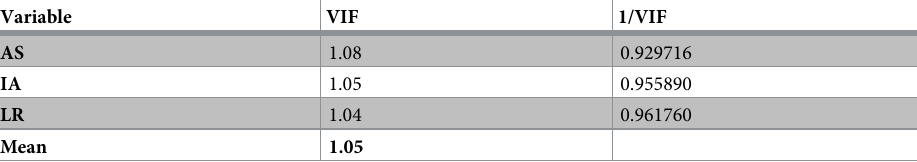
Table 9. Test for multi-collernerity.